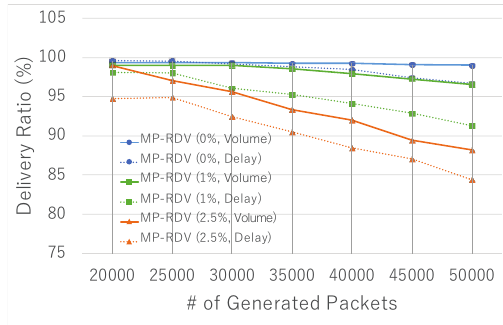
Figure 15. Metric Comparison under Variation on Data Rate.